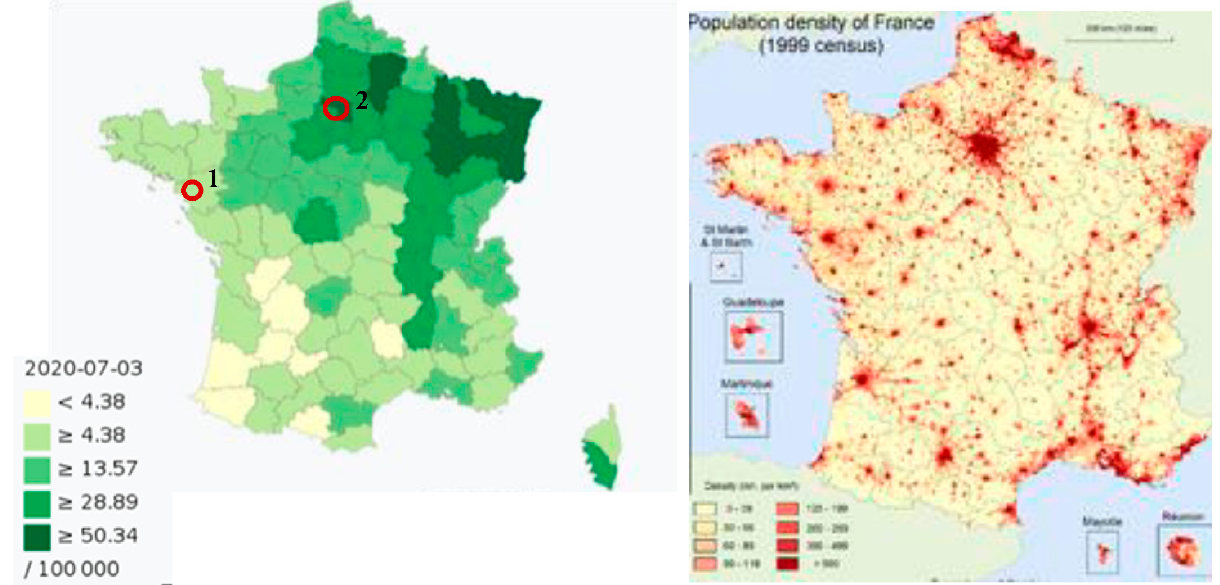
Figure 1. ( Left ): Number of deaths per 100000 residents by French departments. The circles denote the capital cities of the regions investigated: 1 = Nantes, 2 = Paris. ( Right ): population density of France. Images modified from https://en.wikipedia.org/wiki/COVID-19_pandemic_in_France (accessed on 19 February 2021) and https://en.wikipedia.org/wiki/Demographics_of_France (accessed on 19/02/2021).